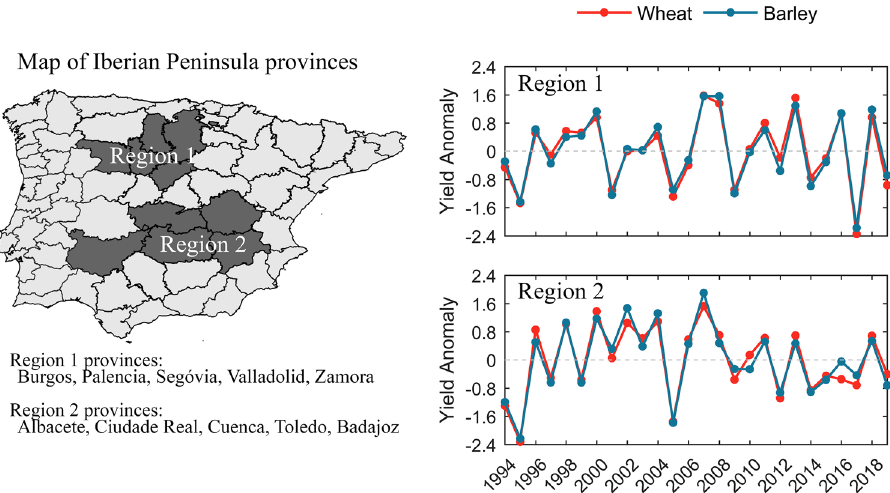
Figure 1. Map highlighting selected adjacent provinces in the Iberian Peninsula, called Region 1 and Region 2 (left), and the respective province names and time series of wheat (orange) and barley (blue) standardized yield anomalies for the period 1993–2019 for Region 1 (right, top panel) and for Region 2 (right, bottom panel). The figure was produced in Python 3.8 (https:// www. python.